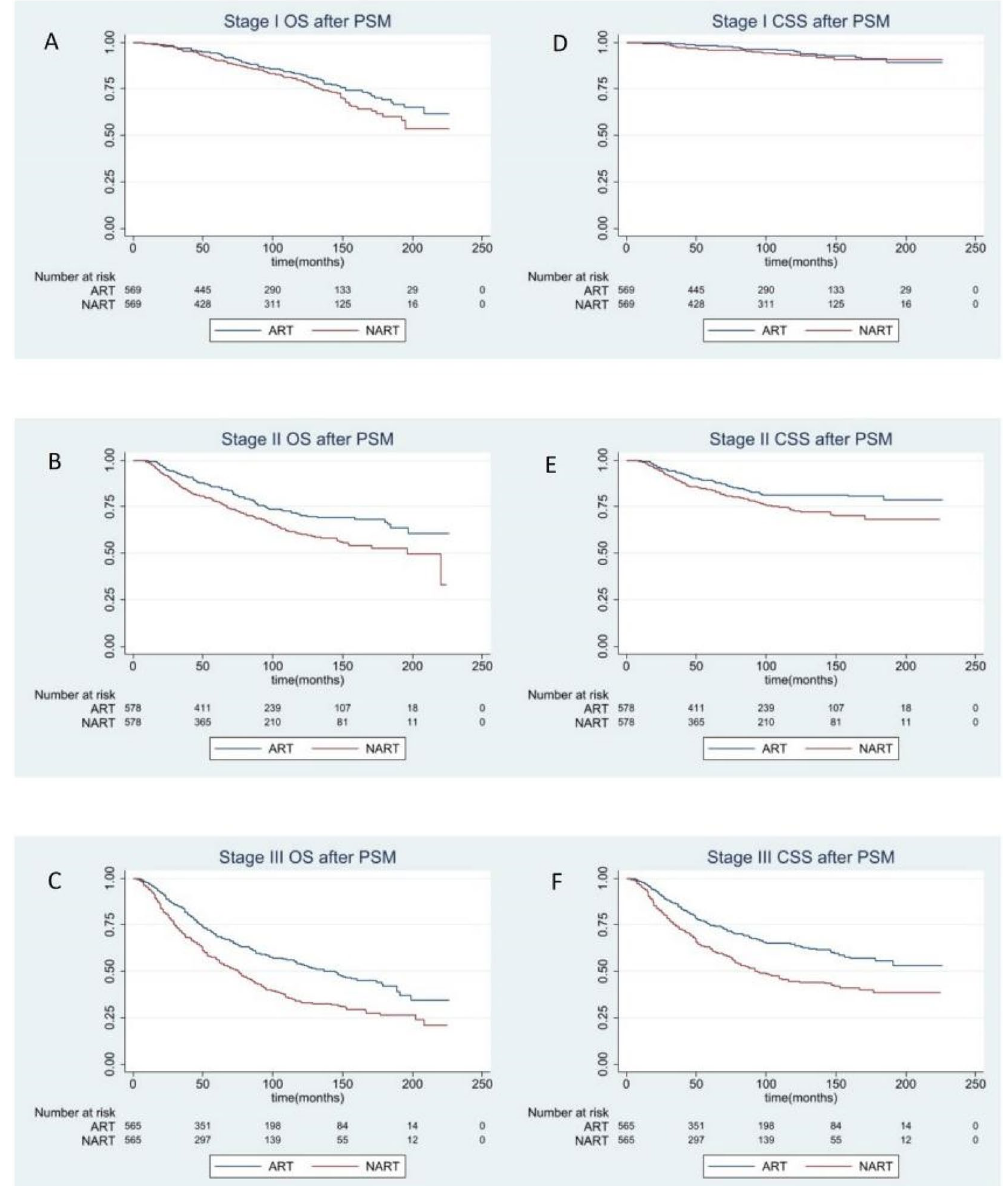
Figure 3. Overall and breast cancer–specific survival by radiation sequence with surgery in the stage subgroup based on propensity score (PS) matching-adjusted survival data. All P values based on PS matching-adjusted, two-sided log-rank test. Left column, overall survival: ( A ) stage I, ( B ) stage II, ( C ) stage III. Right column, breast cancer–specific survival: ( D ) stage I, ( E ) stage II, ( F ) stage